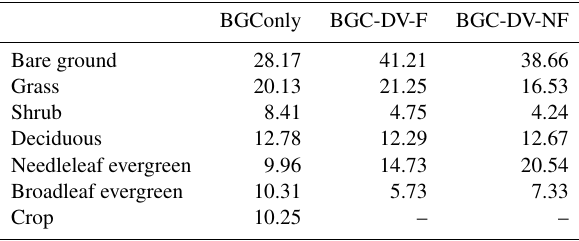
Table 2. Percentage (%) land cover types (bare ground, grass, shrub, deciduous, needleleaf evergreen, and broadleaf evergreen) in BG- Conly, BGC-DV-F, and BGC-DV-NF.